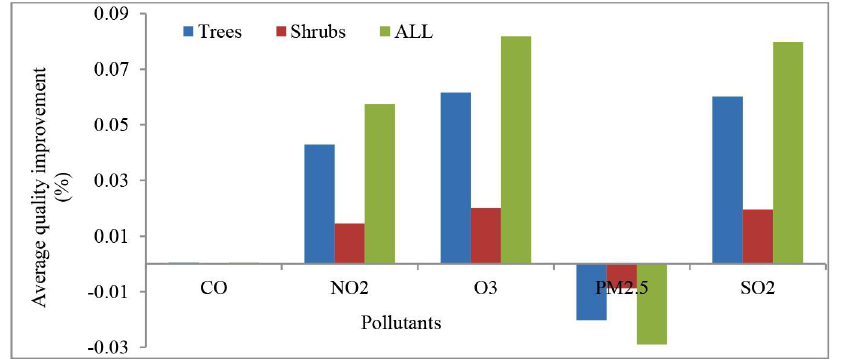
Fig 6. Average percentage of air quality improvement by urban trees and shrubs at the city scale.